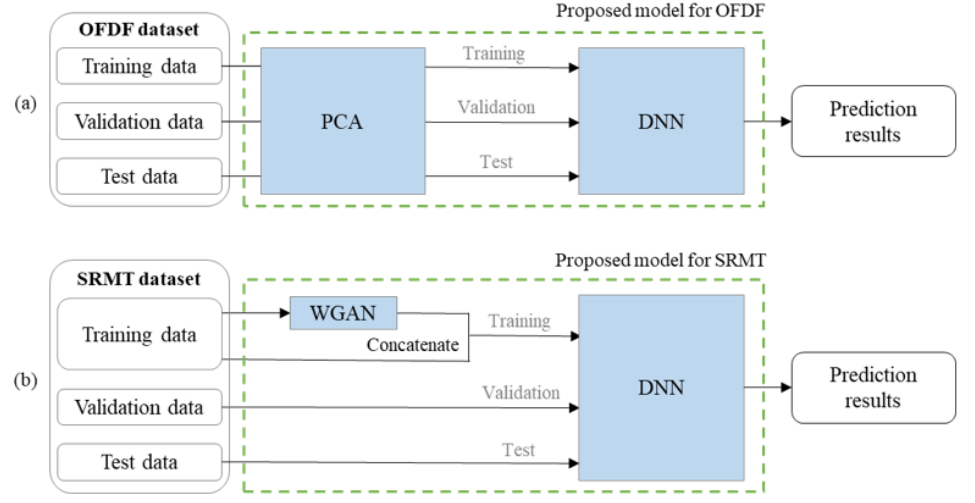
Figure 1. Architecture of two proposed models. ( a ) OFDF; ( b )